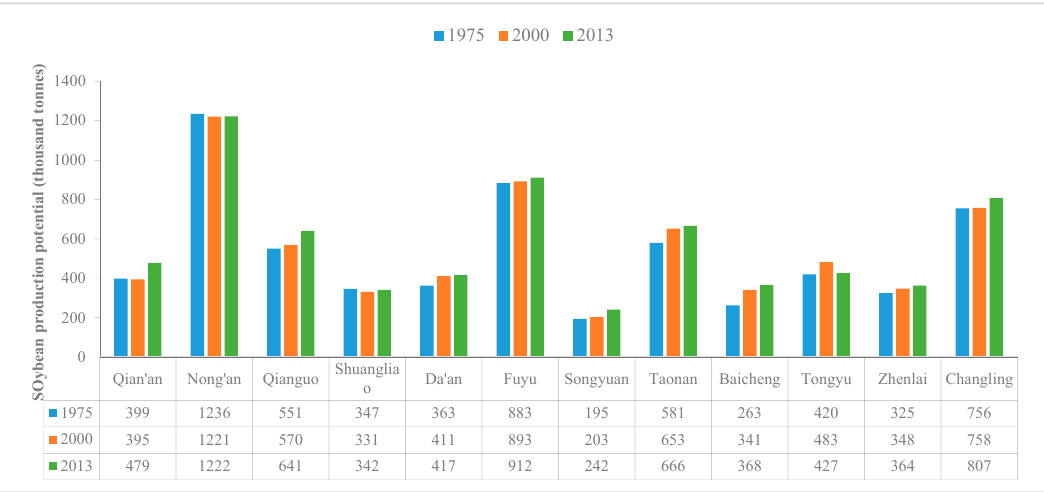
Figure 11. Soybean production potential in Western Jilin in 1975, 2000 and 2013 under Scenario II.